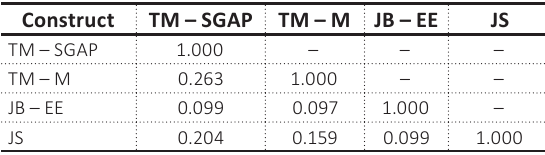
Table 3. HTMT matrix for the measurement model